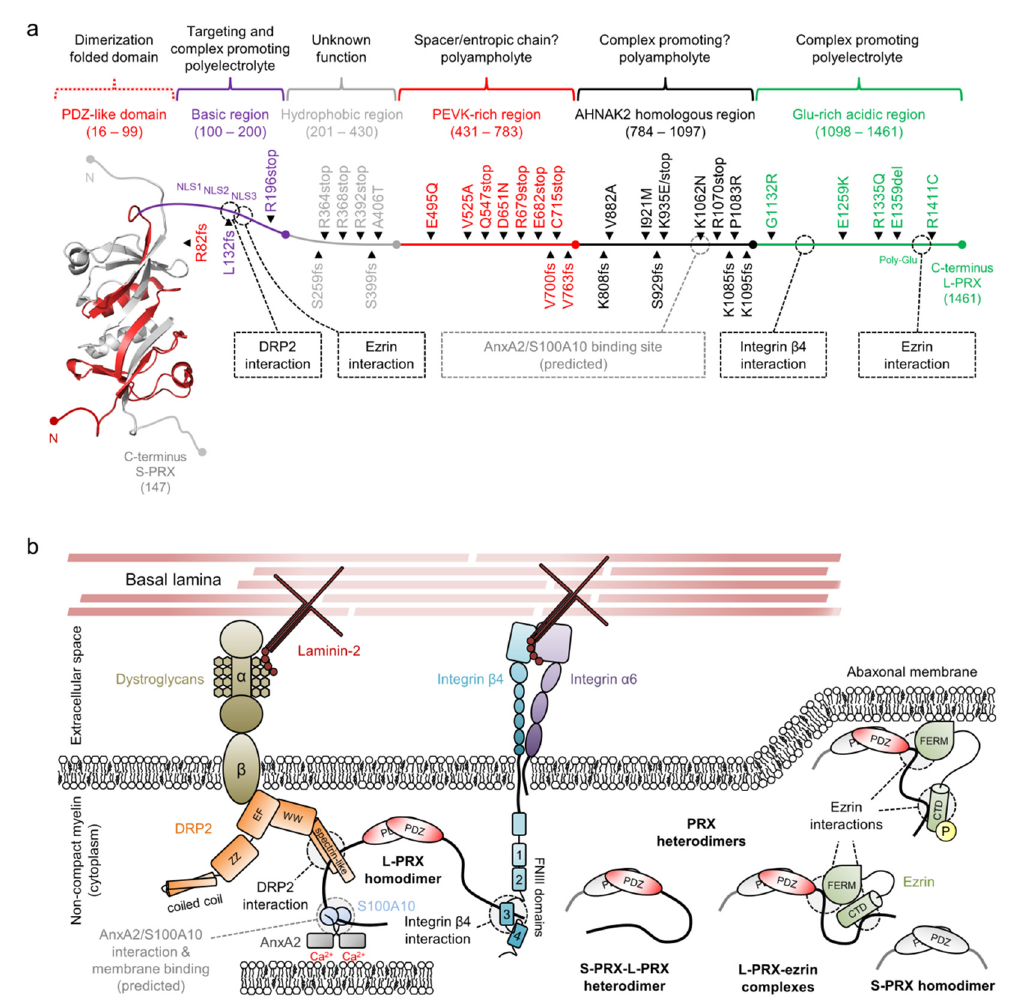
Figure 8. The structure and interactions of periaxin. ( a ) A schematic of a PRX heterodimer, with S-PRX in gray and L-PRX colored based on region, with the PDZ domain in red. L-PRX, apart from the PDZ-like domain, is predicted to be disordered [45], and can be divided into separate regions based on sequence composition. Peripheral neuropathy mutations are indicated alongside L-PRX. Dashed boxes and lines denote protein–protein interactions. L-PRX contains a predicted AnxA2 and S100A10 binding region, as reported earlier for AHNAK [195,196]. See Table 1 for mutation details. ( b ) L-PRX is an assembler within abaxonal non-compact myelin, linking dystroglycans and integrins together in membrane appo- sitions, forming the periaxinosome. These interaction partners connect the Schwann cell basal lamina to the Schwann cell cytoplasm. S-PRX forms heterodimers with L-PRX, which might allow regulation of the cytoplasmic assembly as well as the nuclear export of L-PRX. Ezrin in complex with hetero- or homodimeric L-PRX might have relevance in such regula- tions, especially considering its phosphoregulated membrane-binding activity [197]. The function of the S-PRX ho- modimer is unknown. The significance of the putative L-PRX/AnxA2/Sl00A10 ternary complex could involve linking the entire assembly via AnxA2 and Ca 2+ to the underlying membrane, possibly forming a structural basis for membrane ap- positions that line Cajal bands in myelinating Schwann cells.